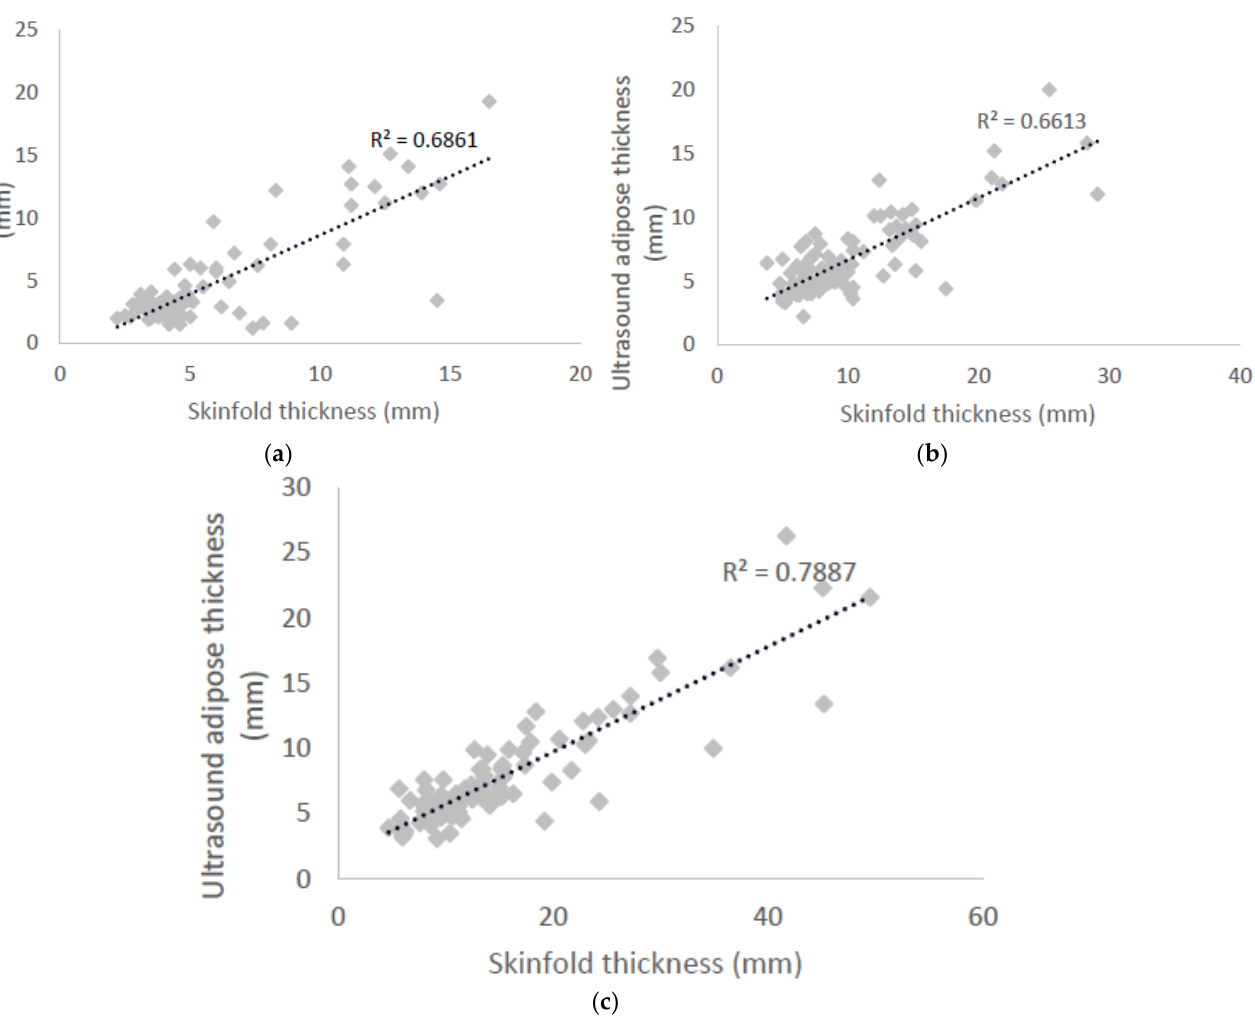
Figure 1. Pearson’s correlation of ultrasound adipose thickness against skinfold thickness for: ( a ) biceps measurement site; ( b ) triceps measurement site; ( c ) front thigh measurement site.